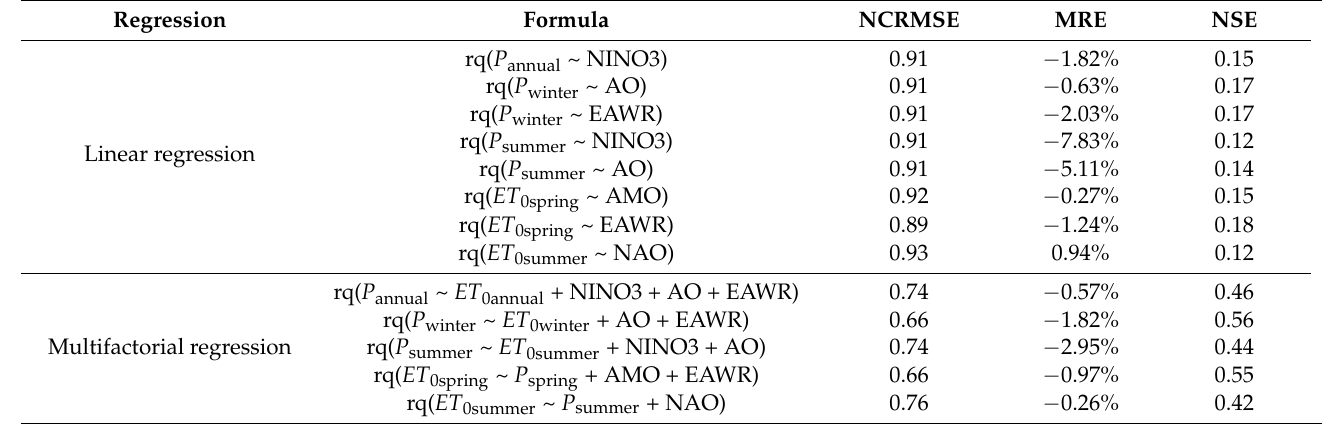
Table 2. Testing the validity of models.